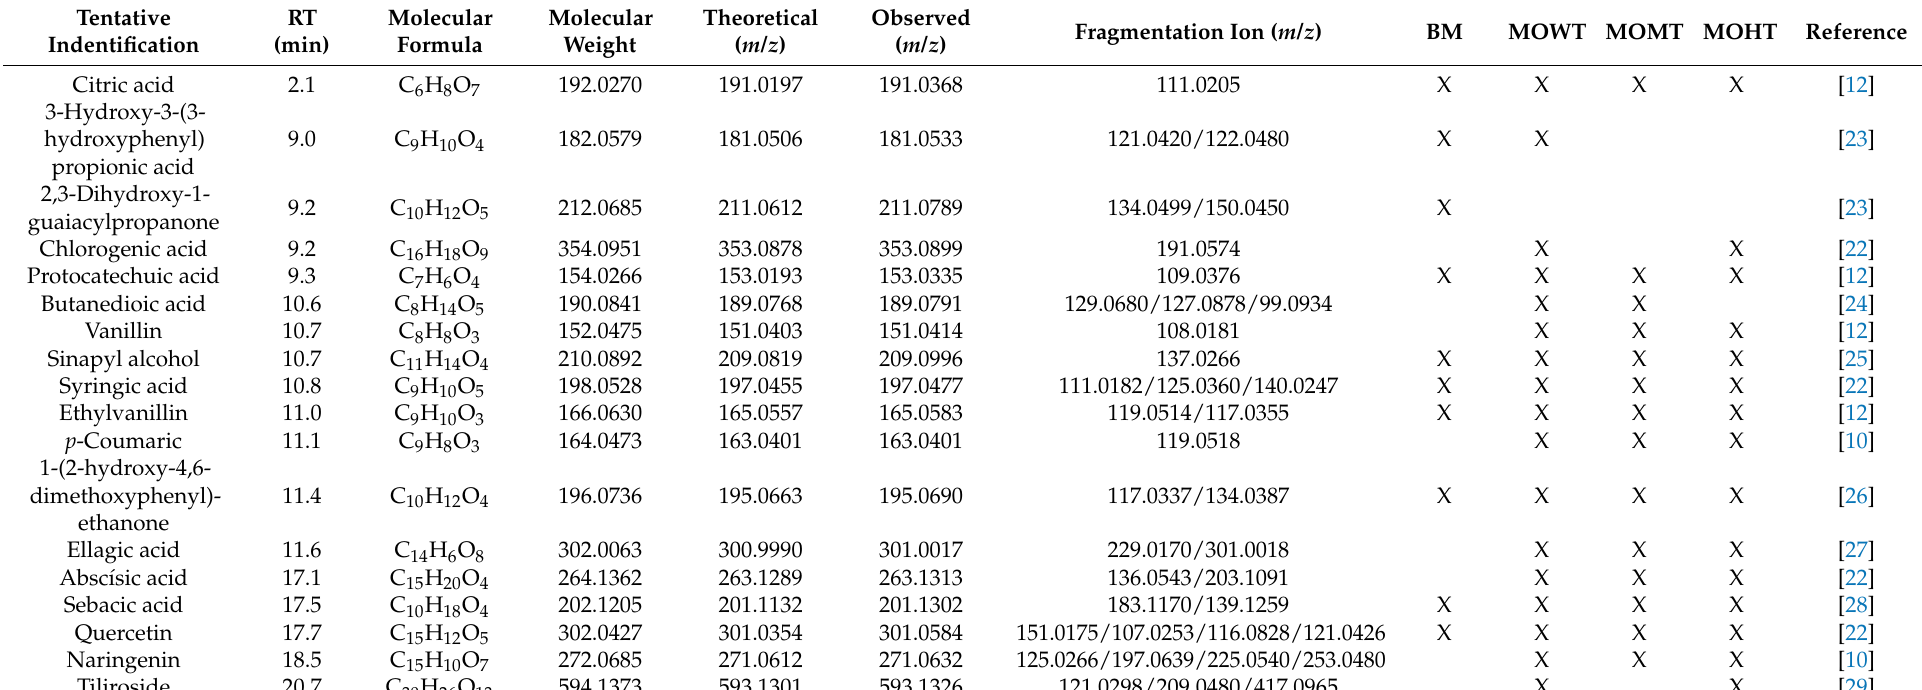
Table 1. Phytochemical compounds detected in mead produced with multifloral honey aged with oak ( Quercus )